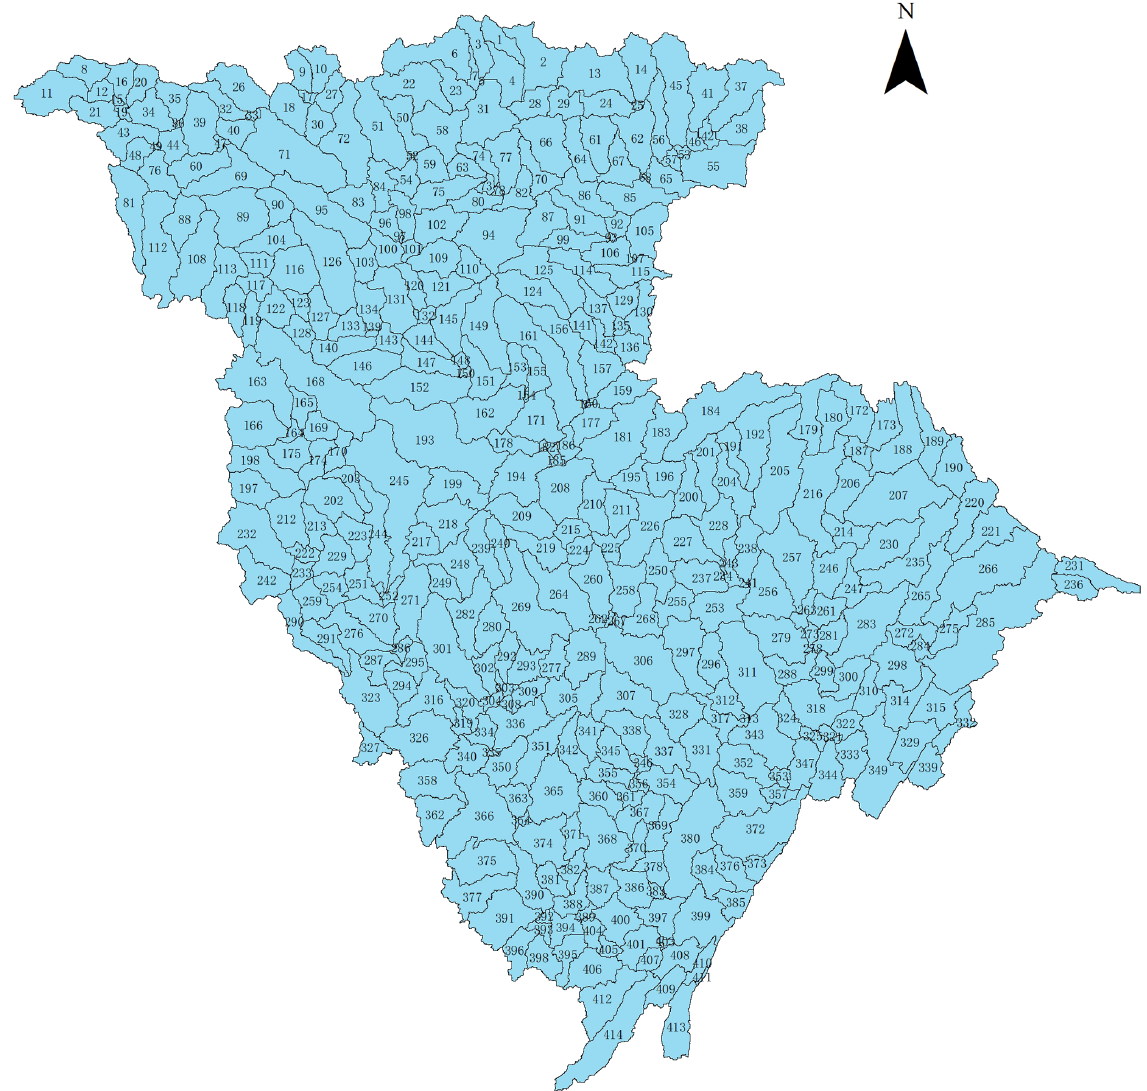
Figure 13. Spatial distribution of subbasins in SWAT named by